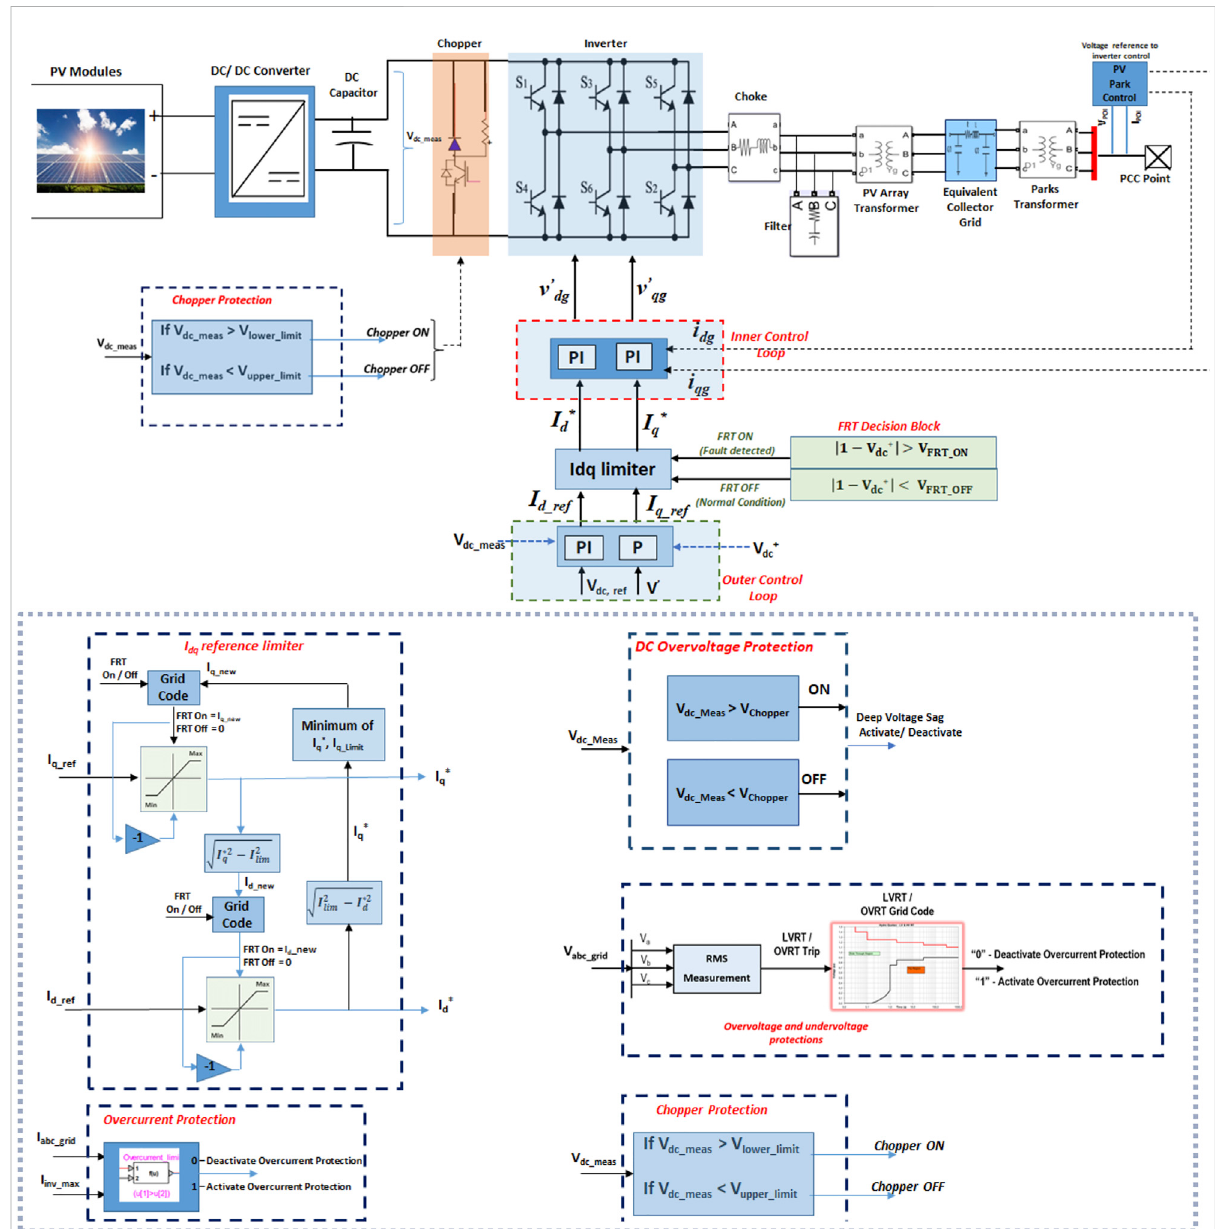
FIGURE 1 Real – reactive FRT control in inverter-fed solar PV